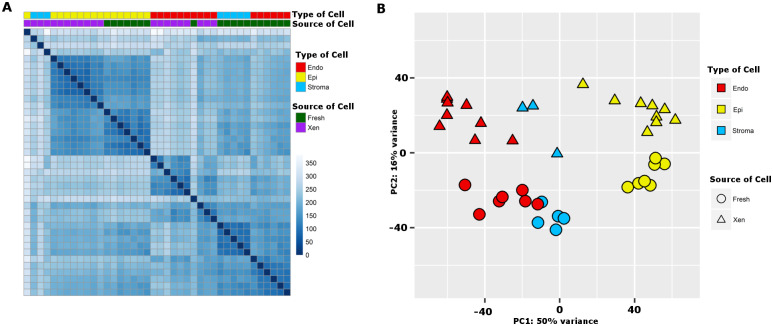
Unsupervised clustering.Un-supervised clustering of transcriptomes of endothelial cells (Endo), epithelial cells (Epi), and stromal cells (Stroma) cells isolated from fresh prostate tissue (Fresh) and primary prostate tissue xenografts (Xen). (A) Un-supervised clustering based on Euclidian distances between sample transcriptomes with samples that are more alike in overall transcriptome being grouped together. Distances scaled from 0 to 350 with darker blue indicating less distance. (B) Principle component analysis of the 40 individual cell type samples from the two tissue sources.